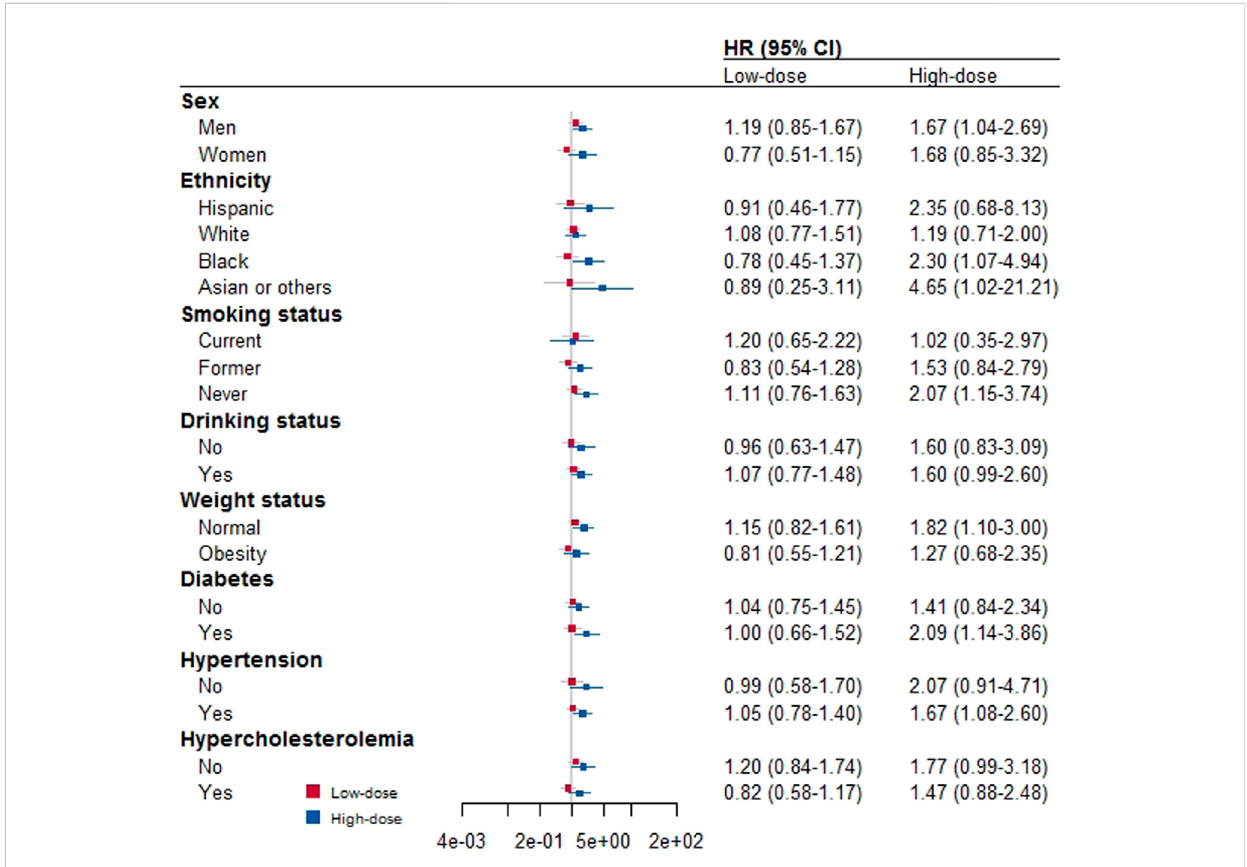
FIGURE 2 Strati fi ed analysis for the association between aspirin use and risk of death by other covariates.